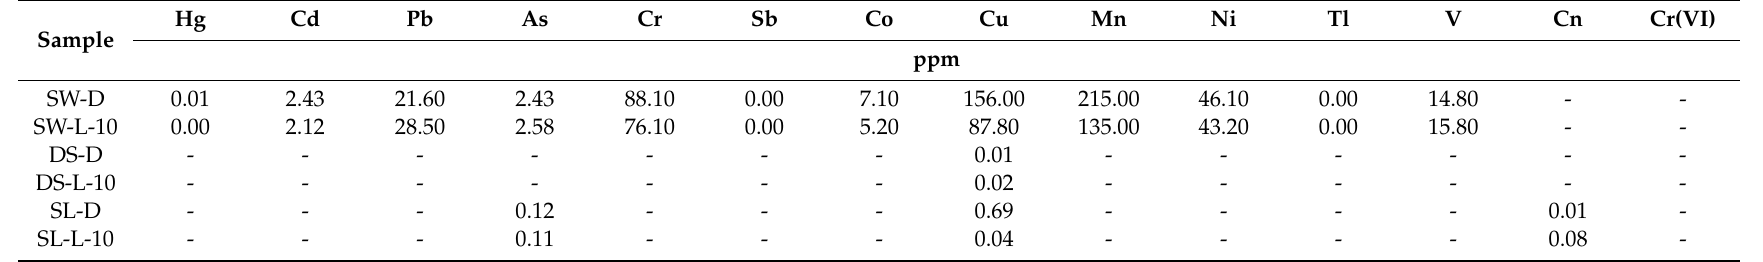
Table 4. Heavy metal components of dried sewage sludges and